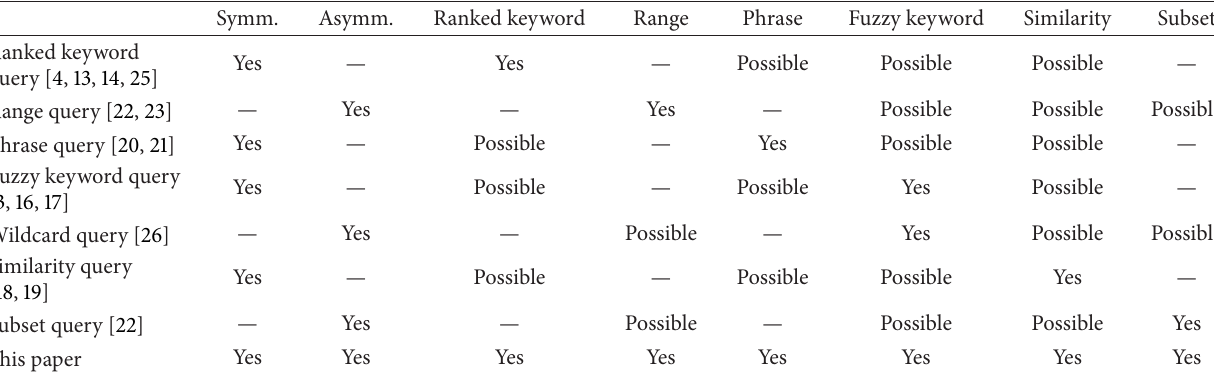
Table 1: Searchable encryption schemes with various